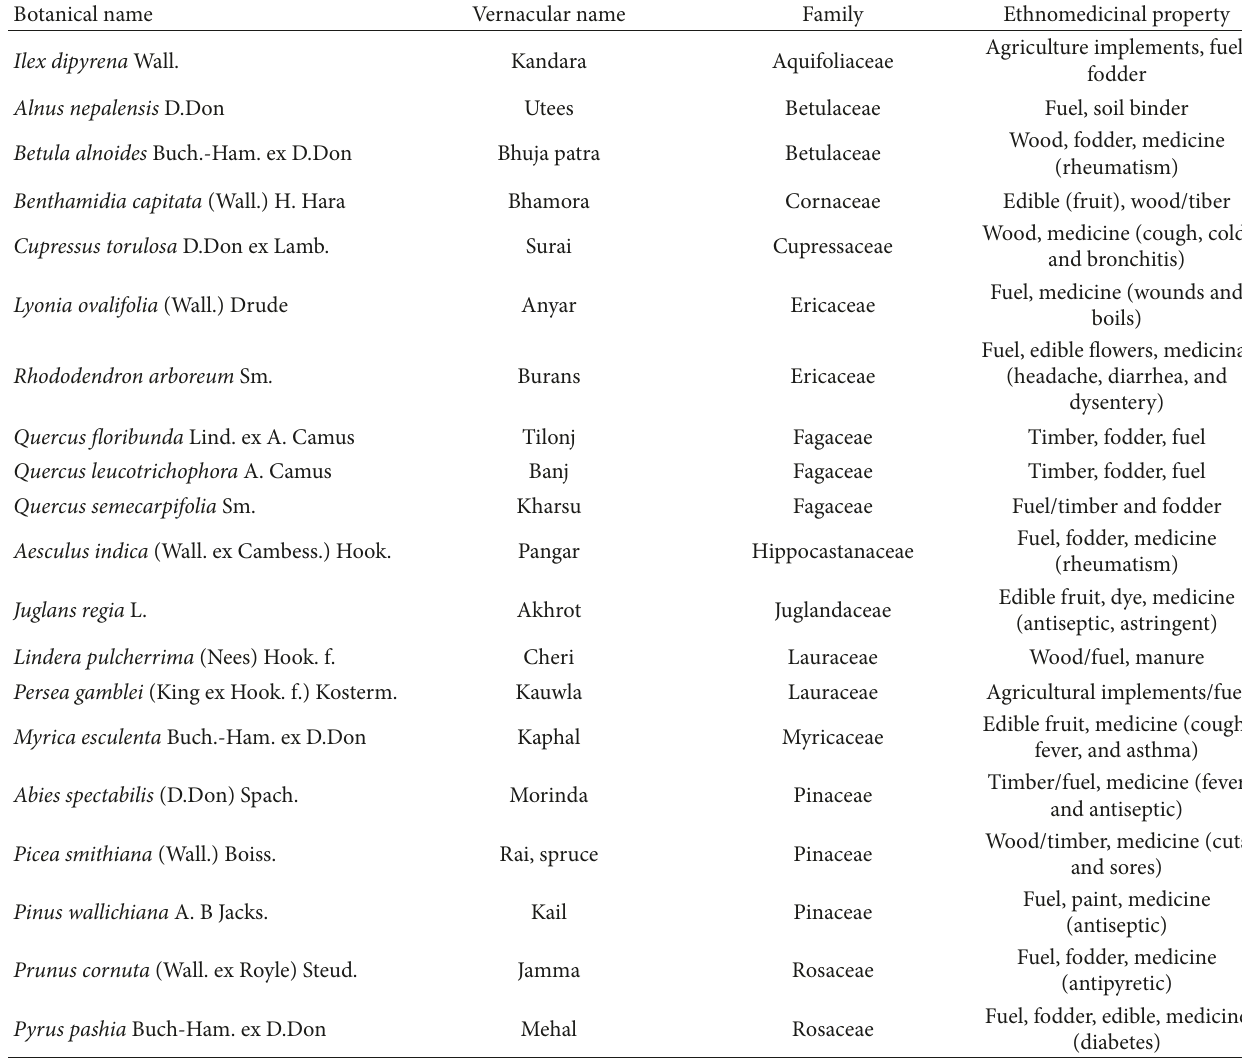
Table 2: List of Tree species (with ethnomedicinal properties) found in Hariyali Devi